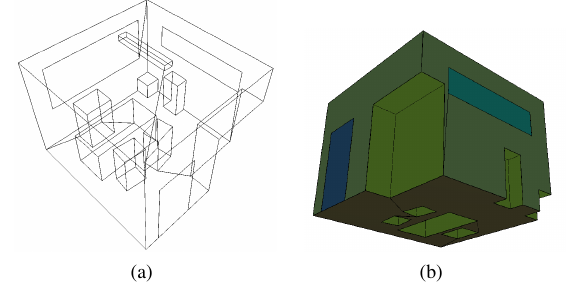
Figure 12: Zoom on a free space 3 -cell from the CAD-house model. (a) Wireframe view showing the layout of the interior. (b) Plain view showing the concavity of the navigable